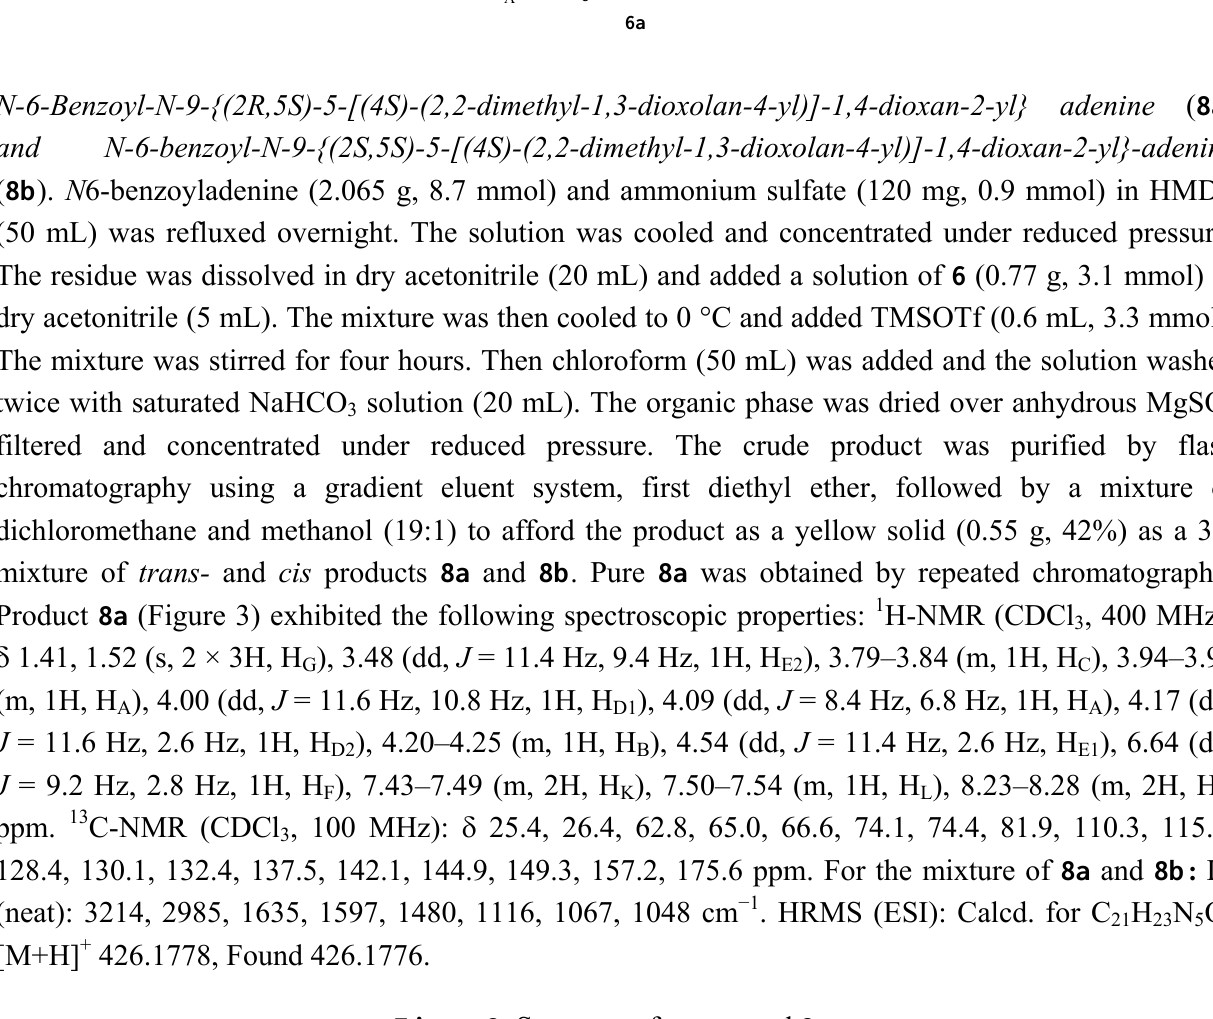
Figure 3. Structure of compound 8a